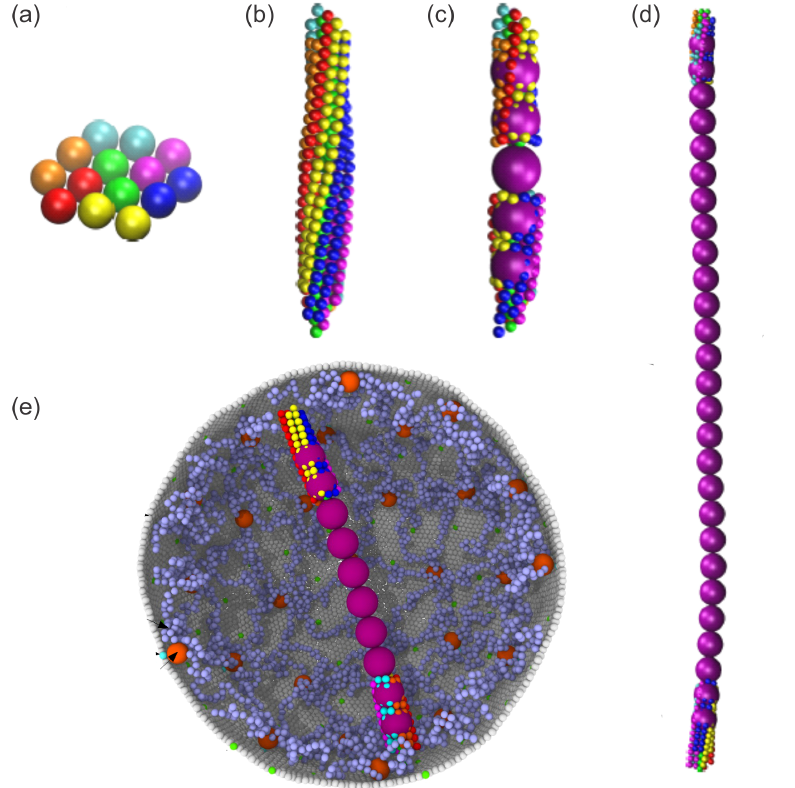
Figure 2. ( a – d ) Sequential snapshots of growth of a HbS fiber simulated by a hybrid HbS fiber model. Reproduced with permission from reference [85]. ( e ) Simulation of the interactions between a spherical RBC [61] and a HbS fiber using a hybrid fiber model